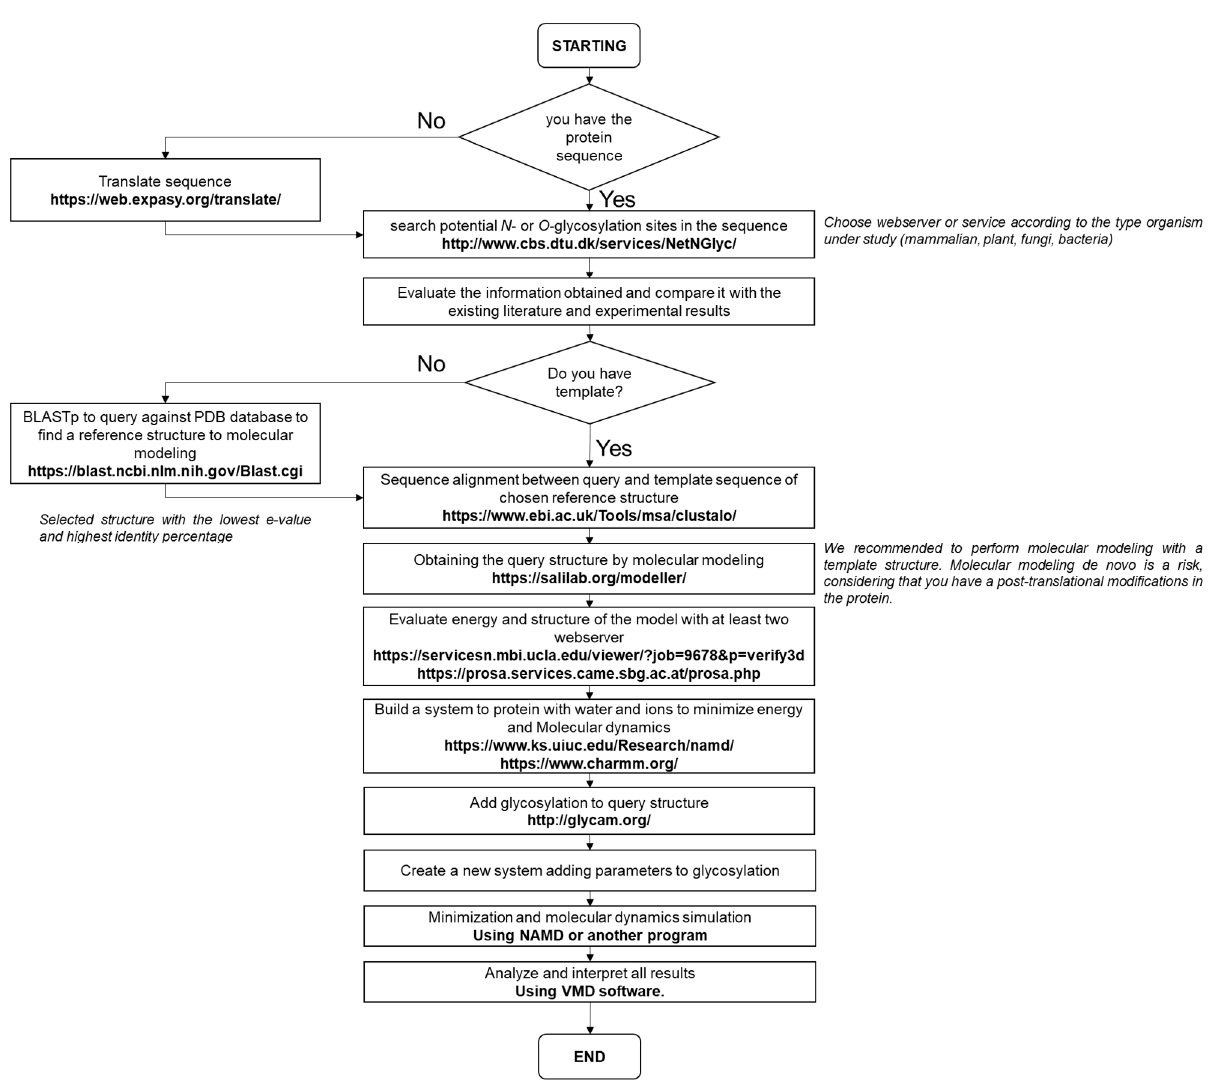
Figure 4. The pipeline proposal is based on the comparative modeling methodology. The pipeline was designed according to the methodology described by Méndez-Yáñez et al. [5].